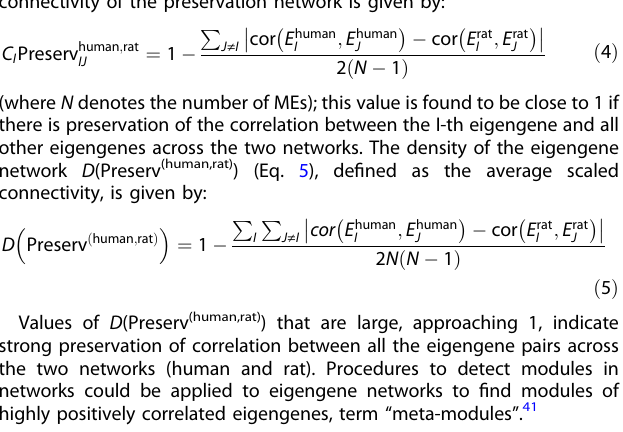
Fig. 6 Development of an OA cartilage gene signature. a Receiver operator characteristic (ROC) curves for gene classi fi ers arising from 10 randomized test and training cohorts using data from the RAAK study, n = 40. 49 Plot shows the true-positive rate (sensitivity, y- axis) against the false-positive rate (1-speci fi city, x- axis). Curves have been staggered at the origin (0,0) for clarity. The area under the receiver operator curve (AUROC), the capacity for a test to distinguish between two groups, is shown in the fi gure legend for each group of genes (Classi fi er). The ROC curve of the random classi fi er (AUROC = 0.5) is shown as a broken line bisecting the plot through the origin. In all cases, the AUROC for selected genes from the H4 module indicated that the probability that these classi fi ers would correctly rank healthy cartilage samples over OA samples was greater than the area under the curve of the random classi fi er. b Principal component analysis of gene expression data from two discriminatory genes ( ARHGDIB , RGS5) derived from the human H4 module to exemplify the division of samples. Data arise from healthy ( n = 7) and osteoarthritic ( n = 33) cartilage samples (class) in young (16 – 18), mid-aged ( > 60), and aged ( > 70) individuals (see key ). The fi rst two principal components (PC1, PC2) described most of the variation between the young and mid-aged/aged samples. This combination of two genes had a representative low classi fi cation error (0.033) using 10-fold cross-validation as a robust estimate. Other combinations of genes were de fi ned for each test, but in all cases ARHGDIB was the top-scoring gene (Supplementary Data SD42). c Expression of ARHGDIB in three age groups ( top panel ) was signi fi cantly different ( p = 3.9e − 05, Kruskall – Wallis test) with cartilage from young donors found to be lower. Expression of the cartilage hallmark gene collagen type II, COL2A1 , ( lower panel ) was more variable across age groups ( p = 3.7e −